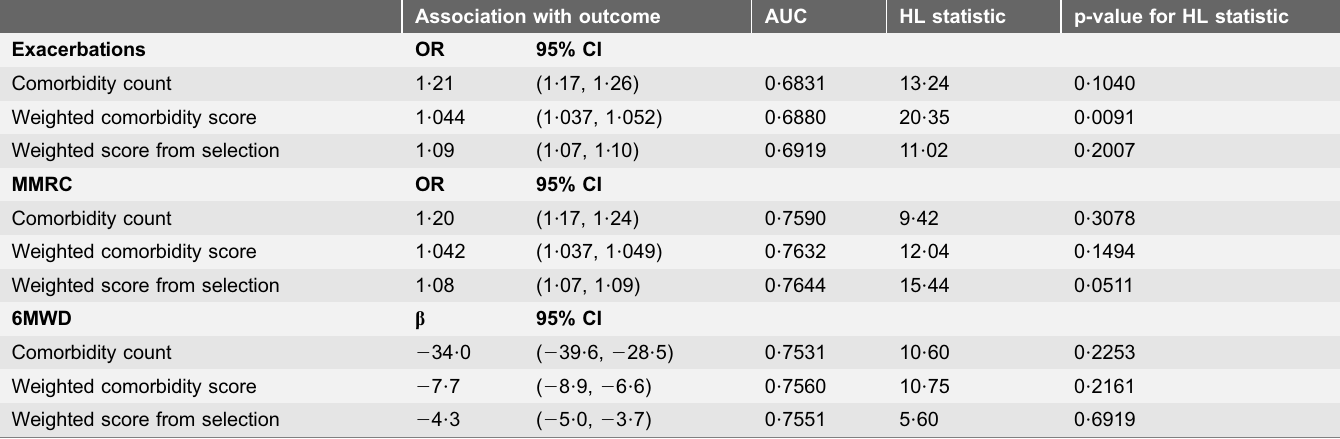
Table 3. Discrimination measures (AUC) and calibration measures (Hosmer-Lemeshow calibration statistics) for comorbidity scores with regards to exacerbations, MMRC, and 6MWD, using COPDGene. Association with